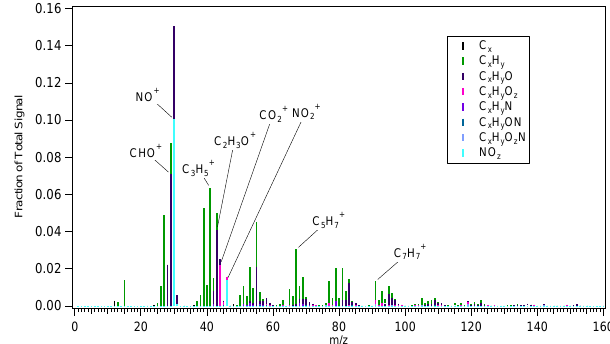
Figure 5. High-resolution aerosol mass spectrum of the SOA formed from the β -pinene + NO 3 reaction under dry, ammonium sulfate seed, and “RO 2 + NO 3 dominant” conditions (Experiment 5 in Table 1). The mass spectrum is colored by the ion type to indicate the contribution of each ion type to the mass spectrum. Only ions up to m/z 160 are shown as the signals beyond m/z 160 are minimal. Ions that contribute significantly to the total signal are also